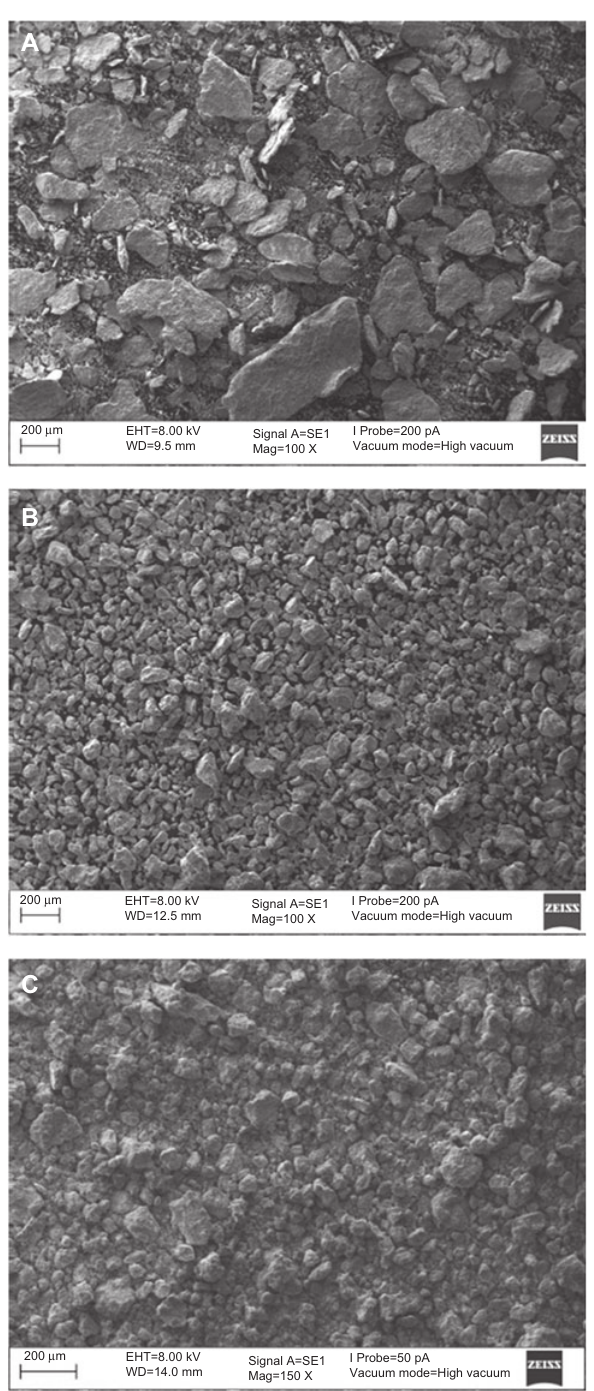
Figure 5 Morphology of Al-10 vol. % Al function of milling time: (A) 0.5 h, (B) 2 h, (C) 7